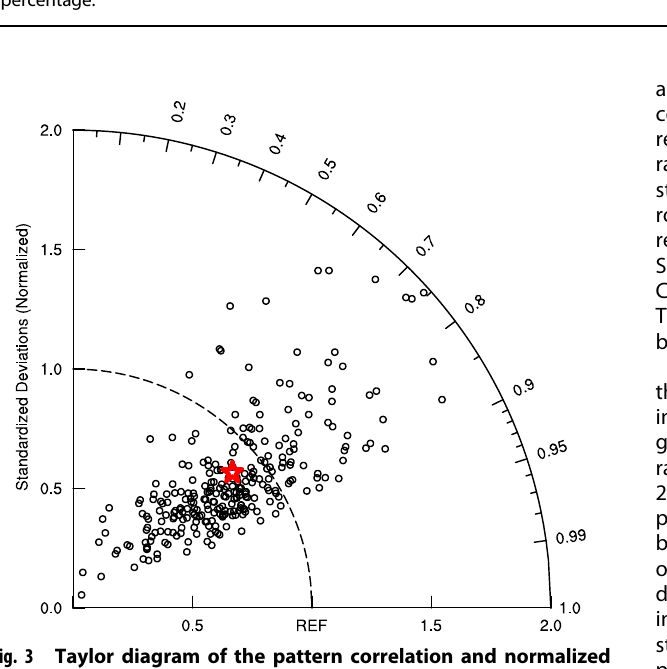
Values are the averages of the total 288 TC landfall cases. Square brackets present range of values (i.e., [min, max]). Parentheses indicate the rate of change in